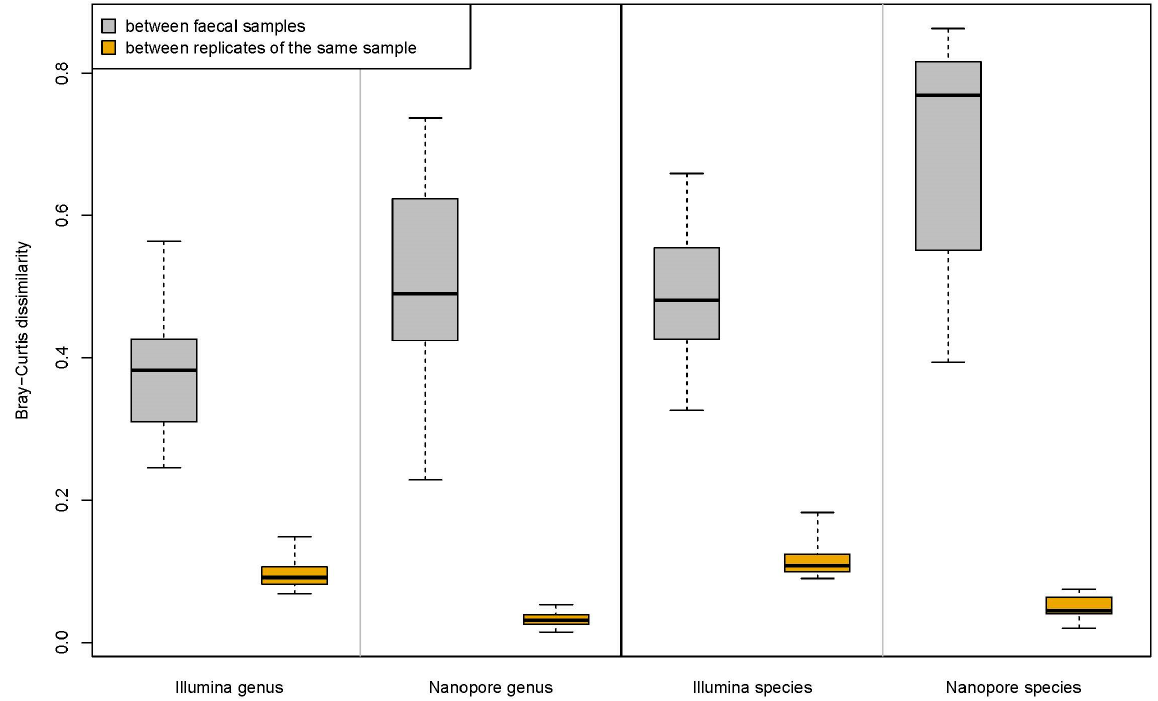
Figure 3. Dissimilarity in bacterial community structure at species- and genus-level taxonomy between technical replicates of the same sample and different faecal samples. The bold lines show the median values, the boxes cover the first to the third quartiles, and the whiskers extend to the data extremes.